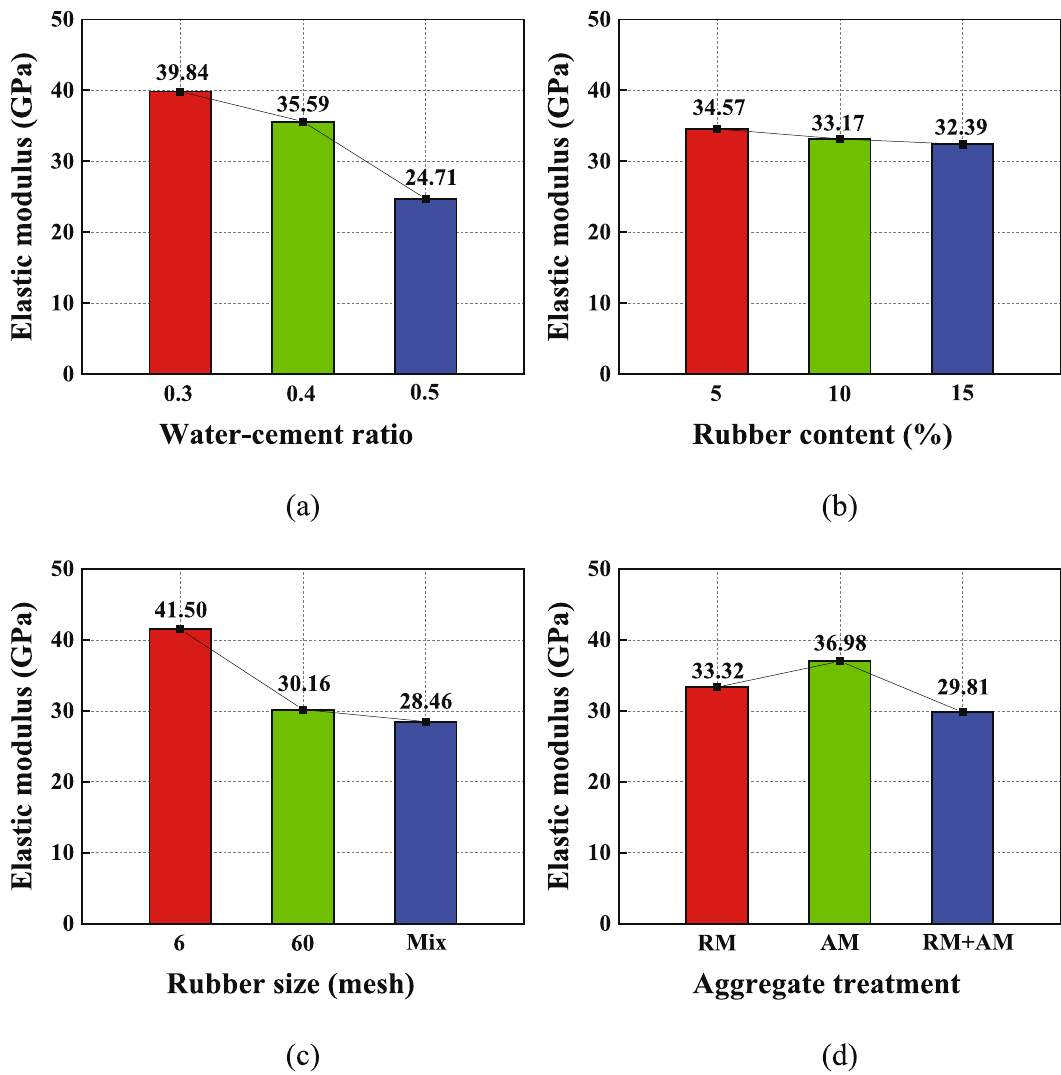
Figure 18: E ff ect of orthogonal factors on elastic modulus of RRAC. ( a ) Water – cement ratio, ( b ) rubber content, ( c ) rubber size, and ( d ) aggregate